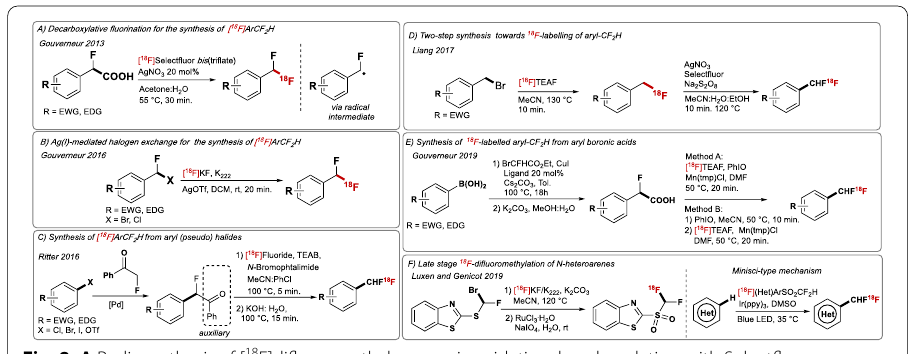
Fig. 8 A Radiosynthesis of [ 18 F]difluoromethylarenes via oxidative decarboxylation with Selectfluor bis (triflate). B Radiosynthesis of [ 18 F]difluoromethylarenes via halogen exchange. C Two-step approach from aryl (pseudo) halides. D Two-step approach from benzyl bromides. E Two-step approach from aryl boronic acids. F New disconnection: late-stage radical 18 F-difluoromethylation with Hu-type [ 18 F]reagent. EWG electron-withdrawing group. EDG electron-donating = =